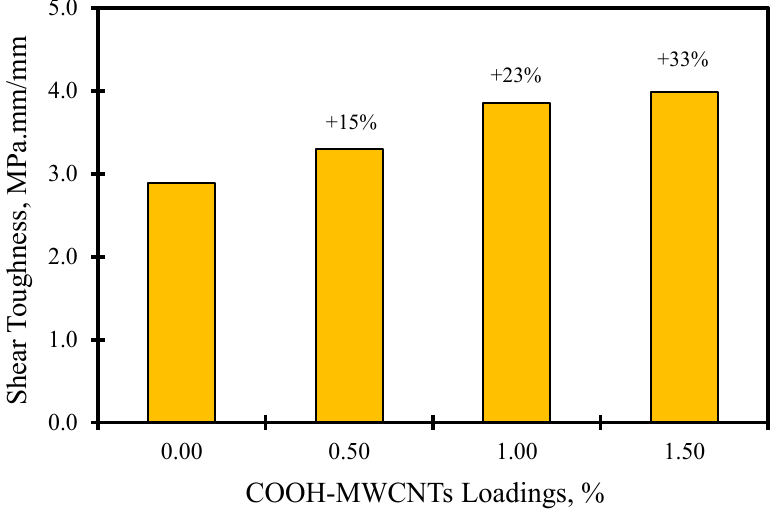
Figure 9. Comparison of shear toughness at the 25% strain level for various wt% of COOH-MWCNTs.